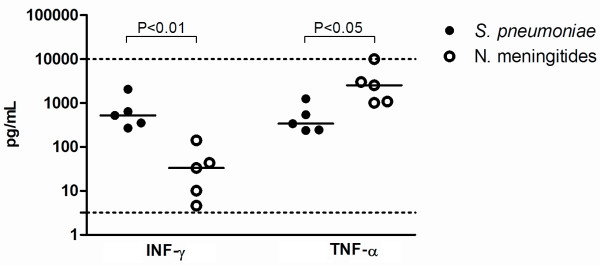
Levels of IFN-γ and TNF-α in the CSF of patients with LP within 48 h (<48 h) from initial symptoms. S. pneumoniae patients showed higher levels of IFN-γ compared to N. meningitidis patients (P < 0.01 by Mann Whitney test). The level of TNF-α in the patients with MM was significantly higher than patients with PM (P < 0.05 by Mann Whitney test). Dotted lines mark the upper and lower limits of detection.